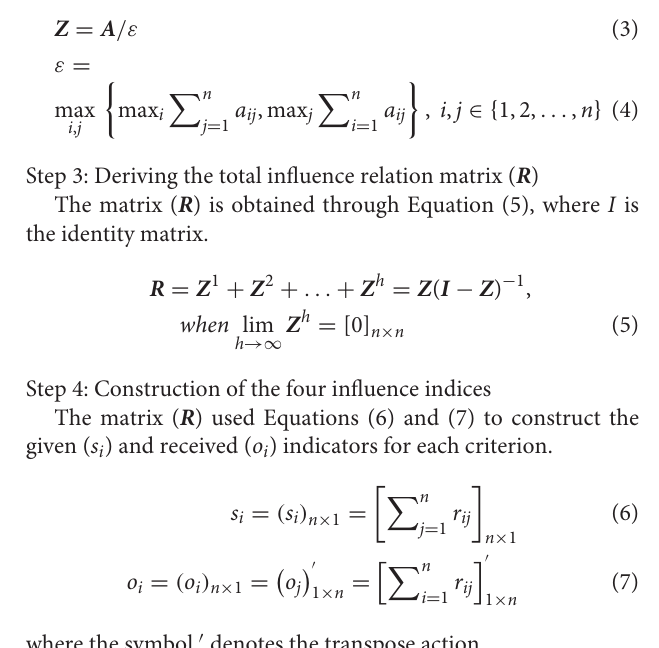
TABLE 2 | The background and characteristics of 13 orthopedic clinical nurses.